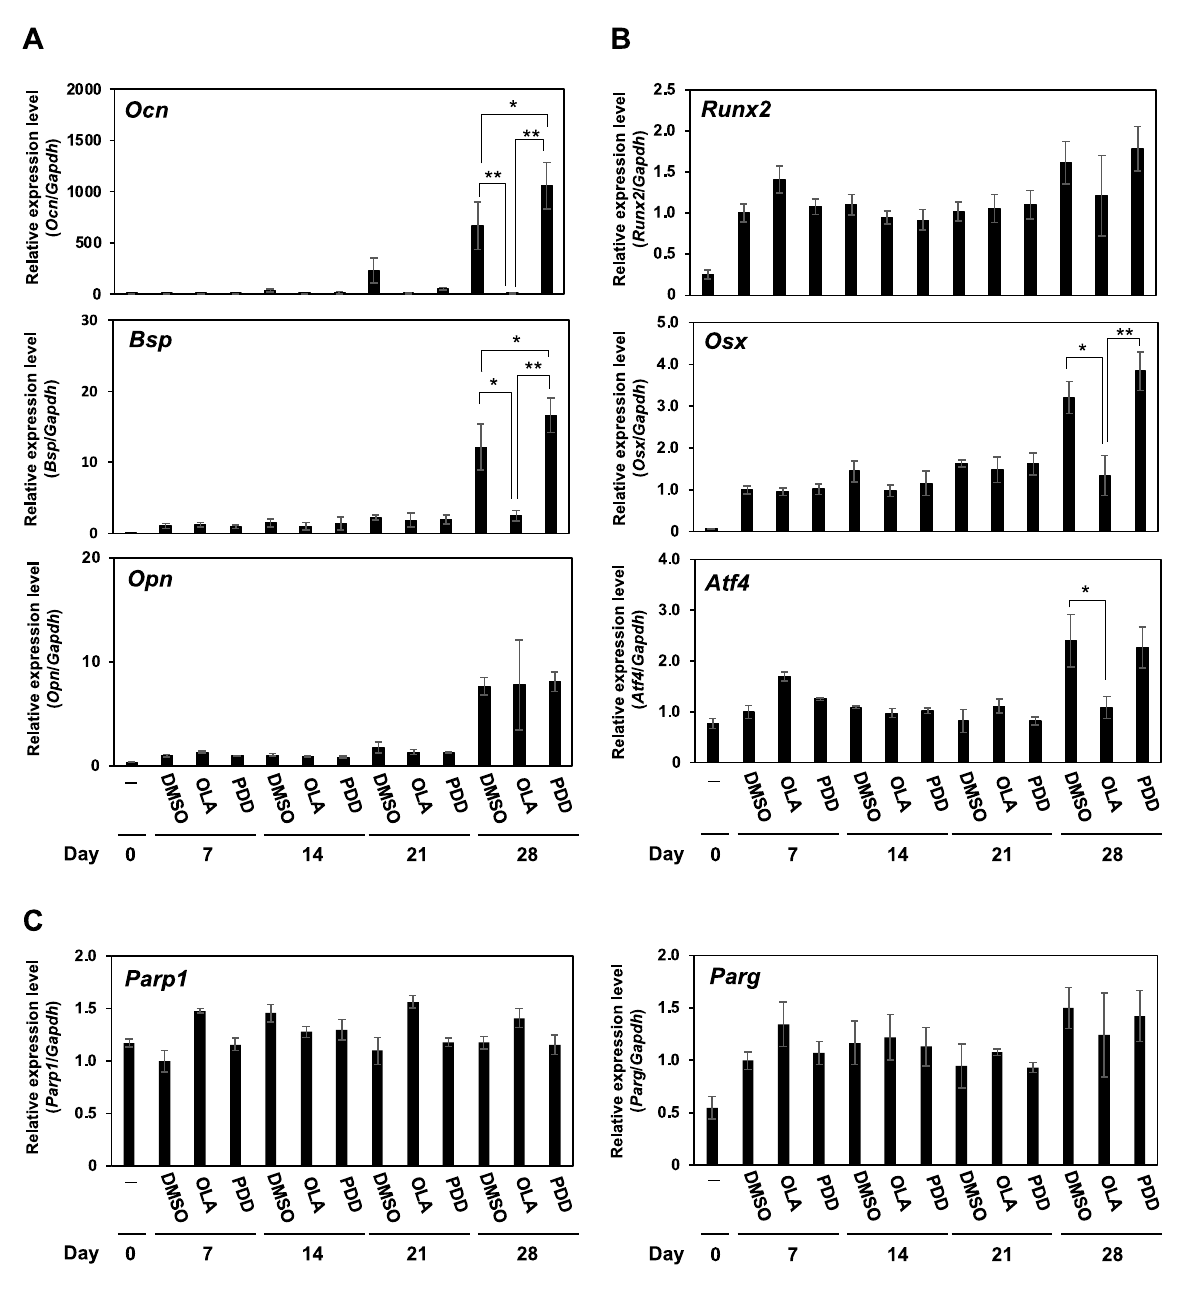
Figure 4. Olaparib downregulates and PDD00017273 upregulates the mRNA expression of osteogenic differentiation-related genes. MC3T3-E1 cells were treated with 1 µ M olaparib, 1 µ M PDD00017273, or DMSO for 0–28 days in differentiation medium. The mRNA expression levels of osteoblast differentiation-related genes were analyzed by qRT-PCR and normalized to the mRNA expression in DMSO-treated cells on day 7 after incubation in differentiation medium. ( A ) Ocn , Bsp , and Opn , as osteoblast differentiation markers. ( B ) Runx2 , Osx , and Atf4 , as transcription factors for osteoblast differentiation. ( C ) Parp1 and Parg . OLA, 1 µ M olaparib; PDD, 1 µ M PDD00017273. Data are shown as mean ± SE. * p < 0.05, ** p < 0.01 (Tukey’s